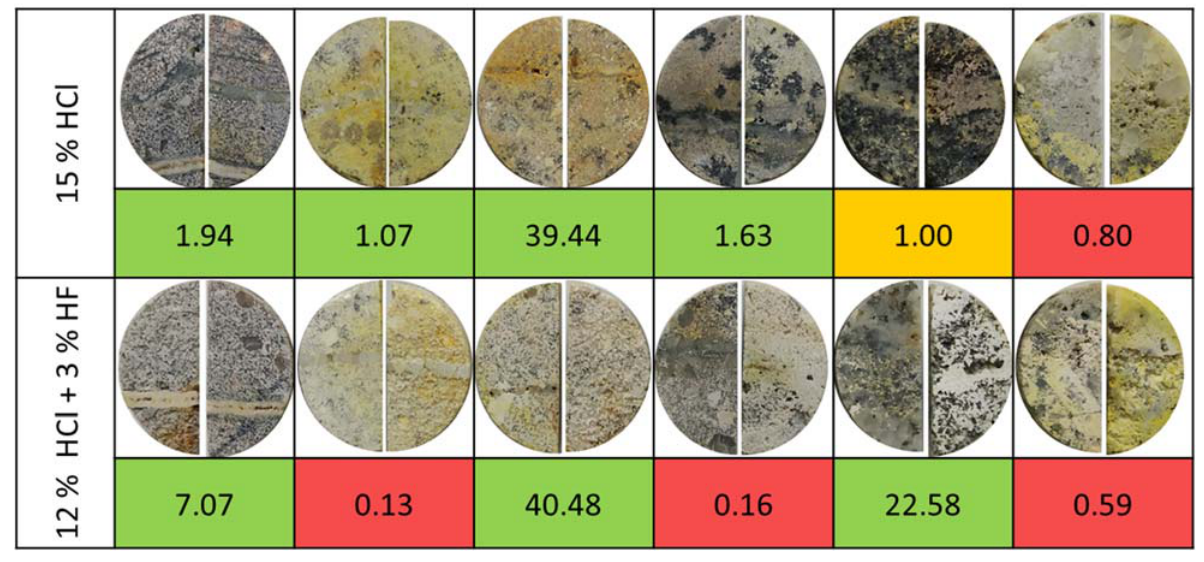
Figure 5. Photomontage of the plugs after acidification, combined with the permeability enhancement factor resulting from treatment with the respective acids 15% HCl or 12% HCl + 3% HF in autoclave experiments: Top ( left ) and bottom ( right ) view of the sawn plugs after the autoclave experiments illustrating the stronger degree of precipitation on the samples bottom surfaces.